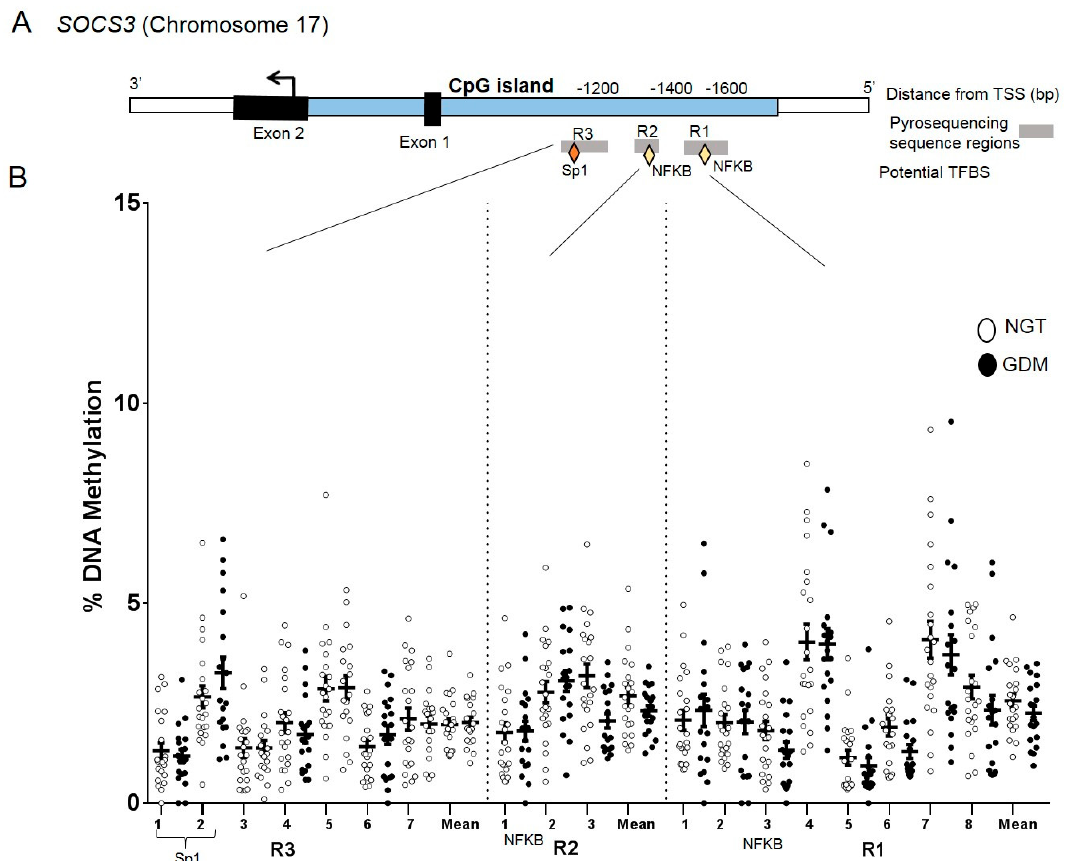
Figure 3. DNA methylation analysis in the SOCS3 promoter region. CpG site-specific DNA methylation analyses at SOCS3 within the promoter region in visceral adipose tissue from mothers with NGT vs. GDM. ( A ) Schematic illustration of the DNA methylation assays (R1, R2, and R3) for the SOCS3 promoter region, including potential transcription factor binding sites (TFBS) Sp1, NFKB (diamonds) and within the CpG island (blue). ( B ) Percent DNA methylation at each individual CpG site investigated (18 CpG sites) in VAT of NGT (white; n = 22) vs. GDM group (GDM; black; n = 19). The overall mean across CpG sites is also included. Data are means ± S.E.M. TSS: Transcriptional start site, bp: base pairs.